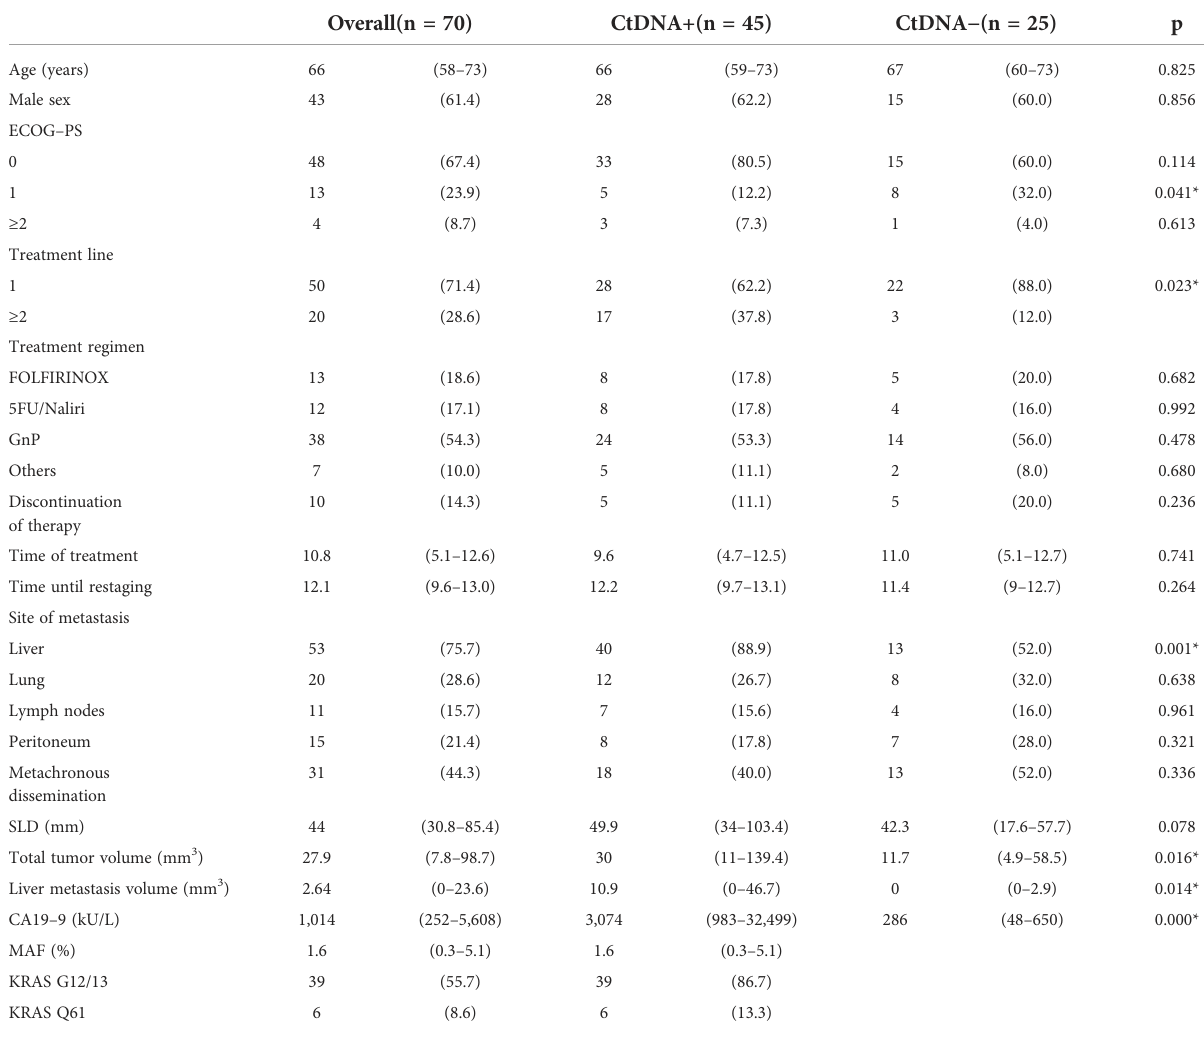
TABLE 1 Patient